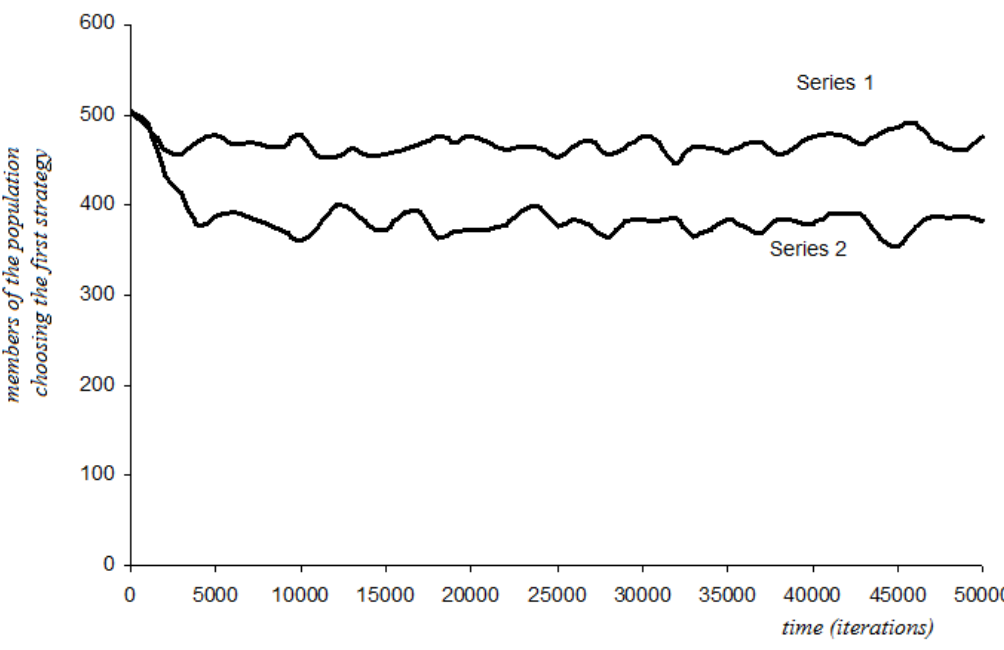
= 0.5. Series 1: a = 0, Series 2: a = 0.33, b = 0